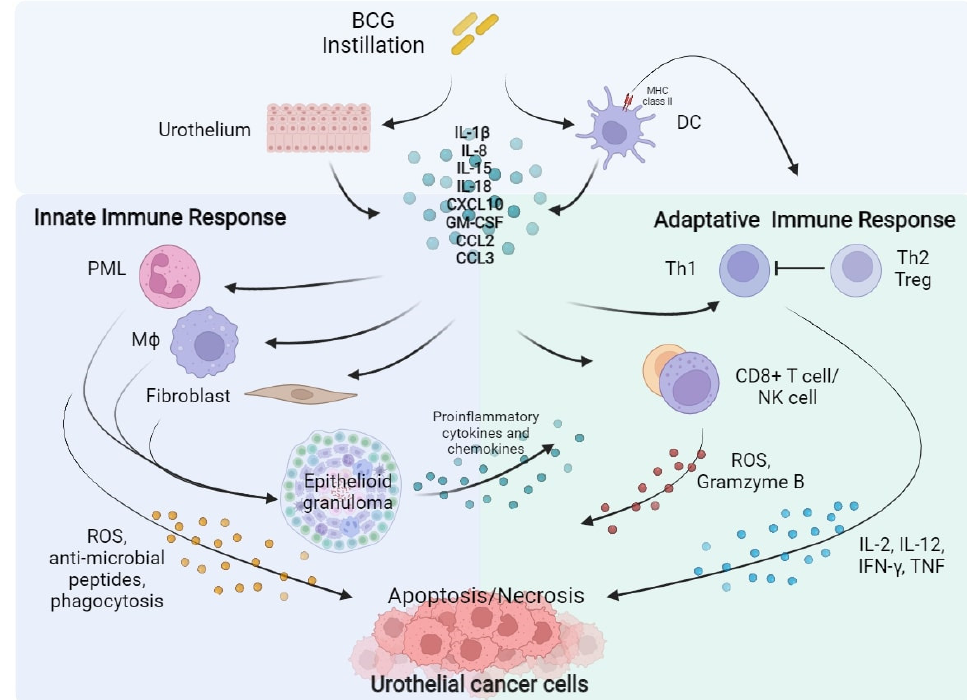
Figure 1. BCG instillation elicits both innate and adaptative immune response against urothelial cancer cells. BCG, Bacillus Calmette–Guérin; DC, Dendritic Cell; IL, Interleukin; CXCL10, C-X-C motif Chemokine Ligand 10; GM-CSF, Granulocyte-Macrophage Colony-Stimulating Factor; CCL2, C-C Motif Chemokine Ligand 2; CCL3, C-C Motif Chemokine Ligand 3; PML, Polymorphonuclear Leukocytes; Th, Helper T cell; Treg, Regulatory T cell; M ϕ , Macrophage; CD8, Cluster of Differentiation 8; NK, Natural Killer; ROS, Reactive Oxygen Species; IFN- γ , Interferon- γ ; TNF, Tumour Necrosis Factor.